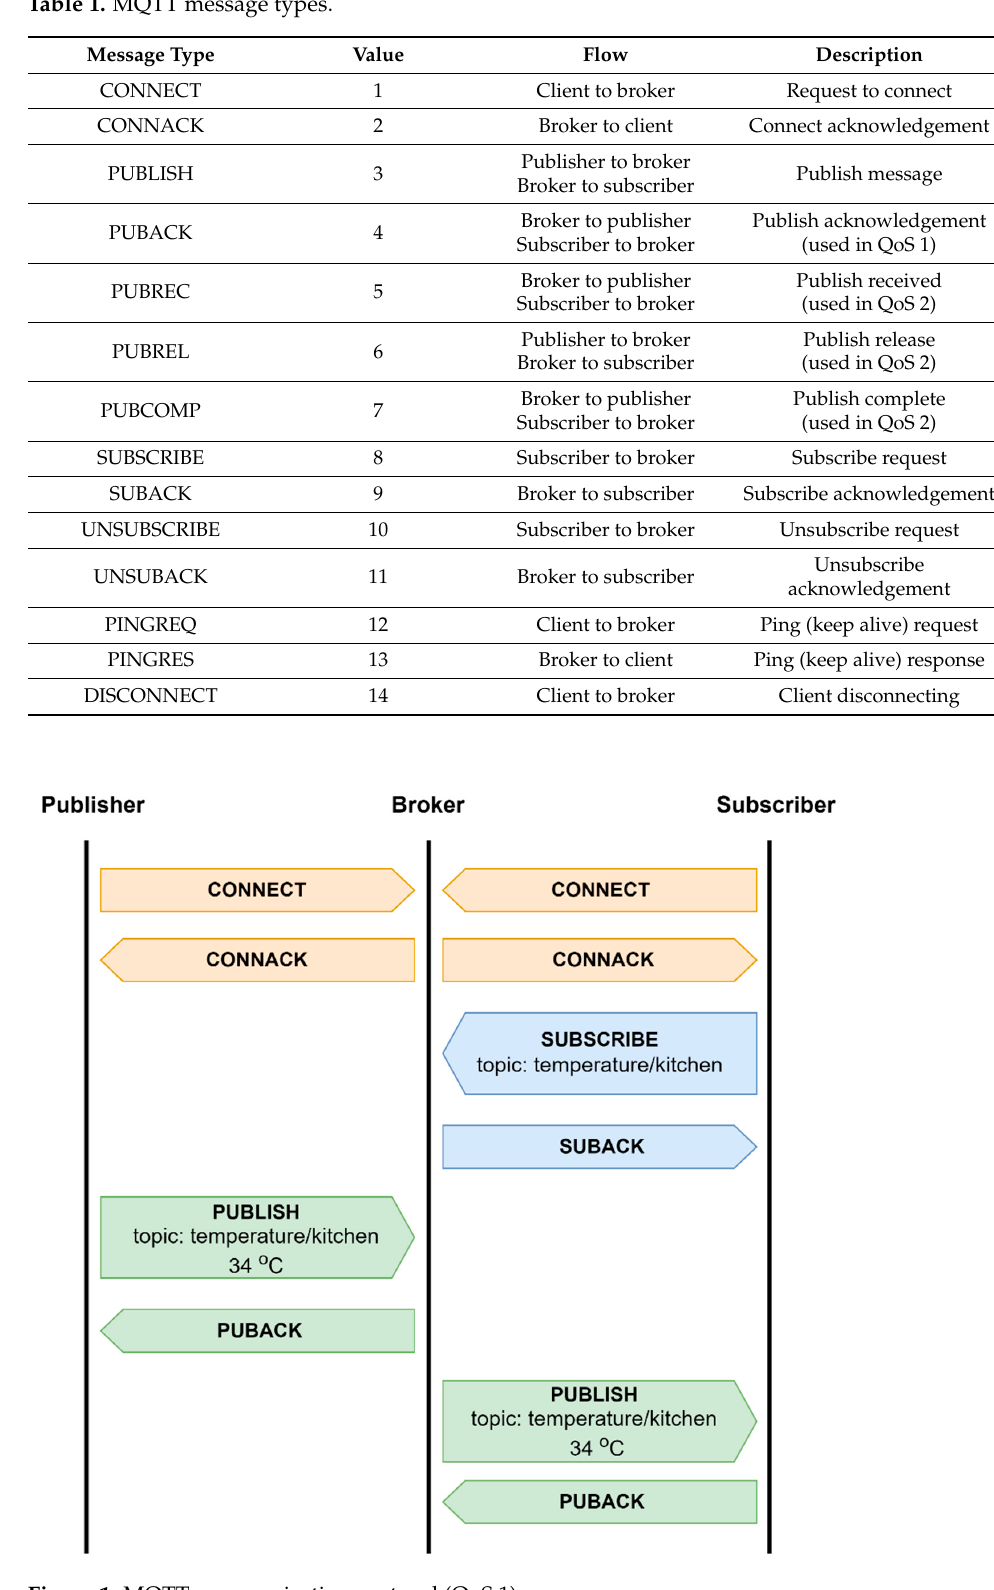
Table 1. MQTT message types.